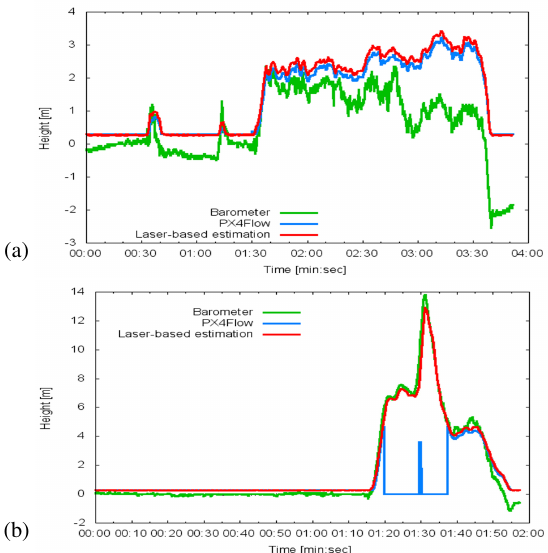
Figure 8: Setup and mounting of stereo camera